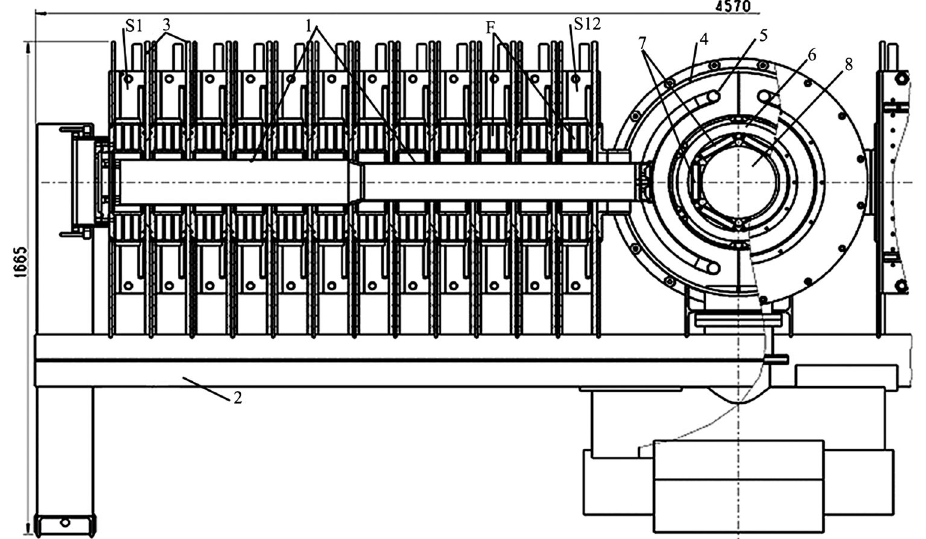
FIG. 9. Assembly drawing of the accelerator: 1—central conductor; 2—basement; S1–S12—12 LTD-4 stages; F —ferromagnetic cores; 4—body of the vacuum chamber; 5—cathode; 6—Xe volume; 7— CaF